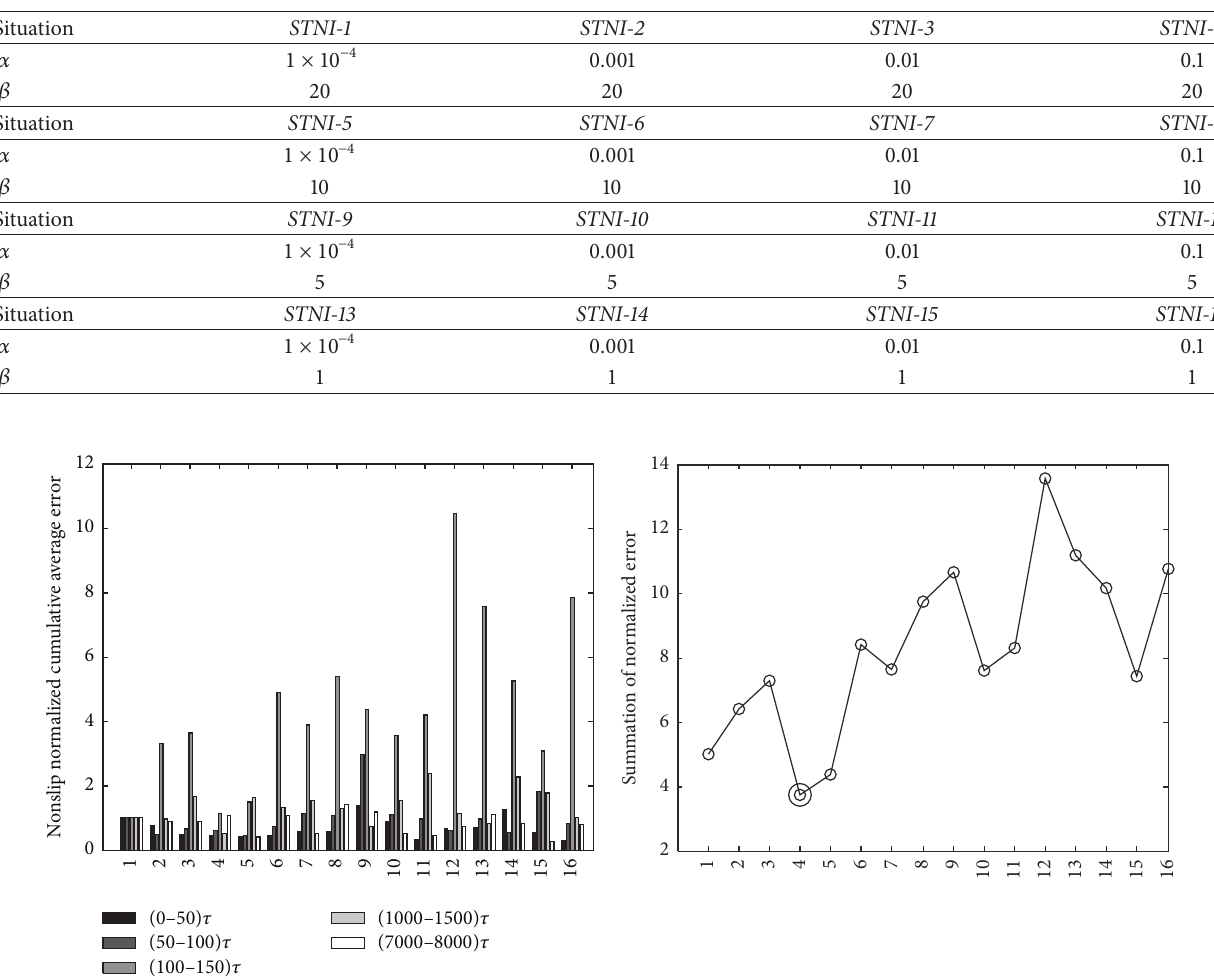
Table 14: Combinations of parameters in the nonperiodic boundary force model with 16 situations.